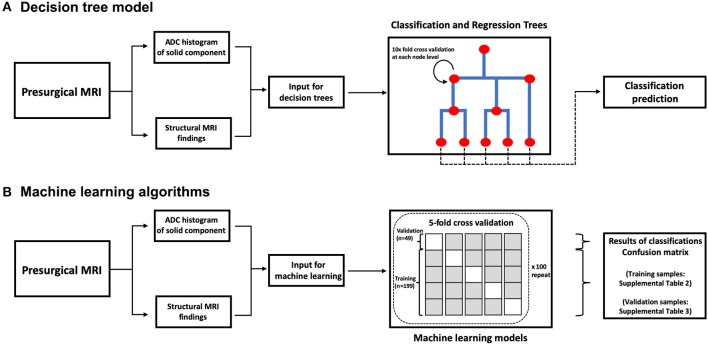
A block diagram of decision tree model (A) and machine learning algorithms (B). ADC, apparent diffusion coefficient.